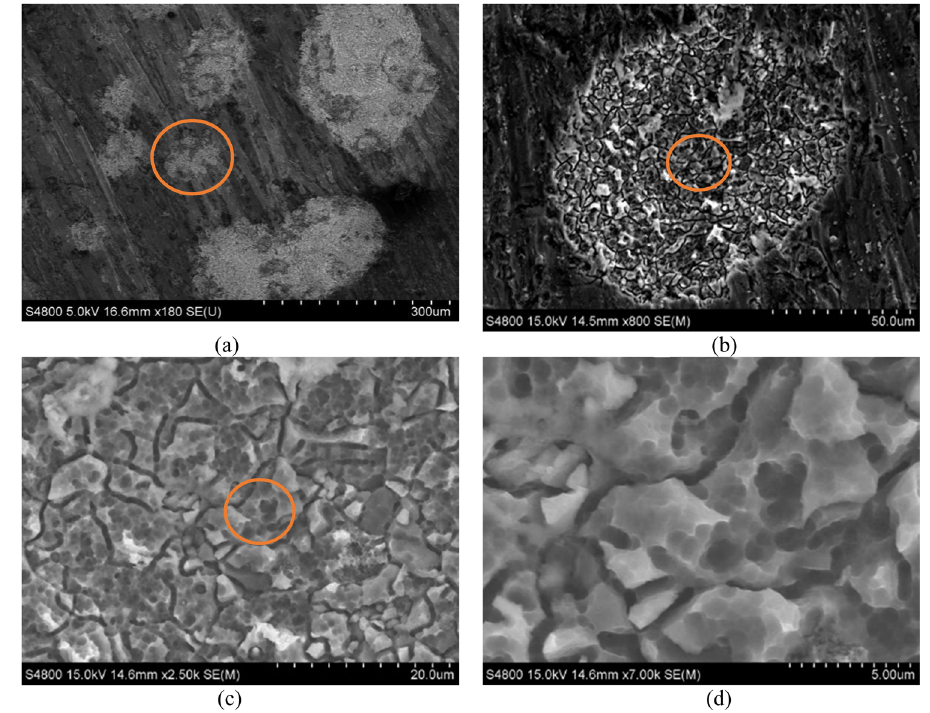
Figure 16: SEM micrograph of aluminium alloy corroded by simulated acid rain: ( a ) 55.3 × , ( b ) 290 × , ( c ) 730 × , and ( d ) 2,920 ×